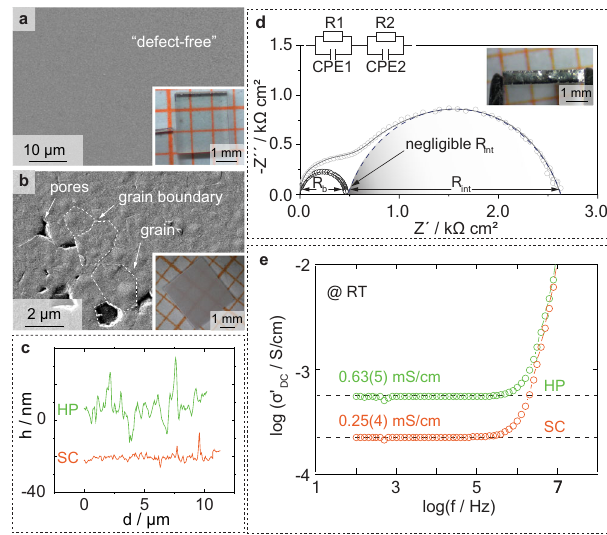
Fig.1|Physicochemicalandelectrochemicalcharacterizationsoftheinorganic solid-state electrolytes. a (inset) Single crystalline Li 6 La 3 ZrTaO 12 (SC) specimen and b (inset) hot-pressed polycrystalline Li 6.4 La 3 Zr 1.4 Ta 0.6 O 12 (HP) specimen in top view after shaping and thorough polishing on millimeter paper. The samples